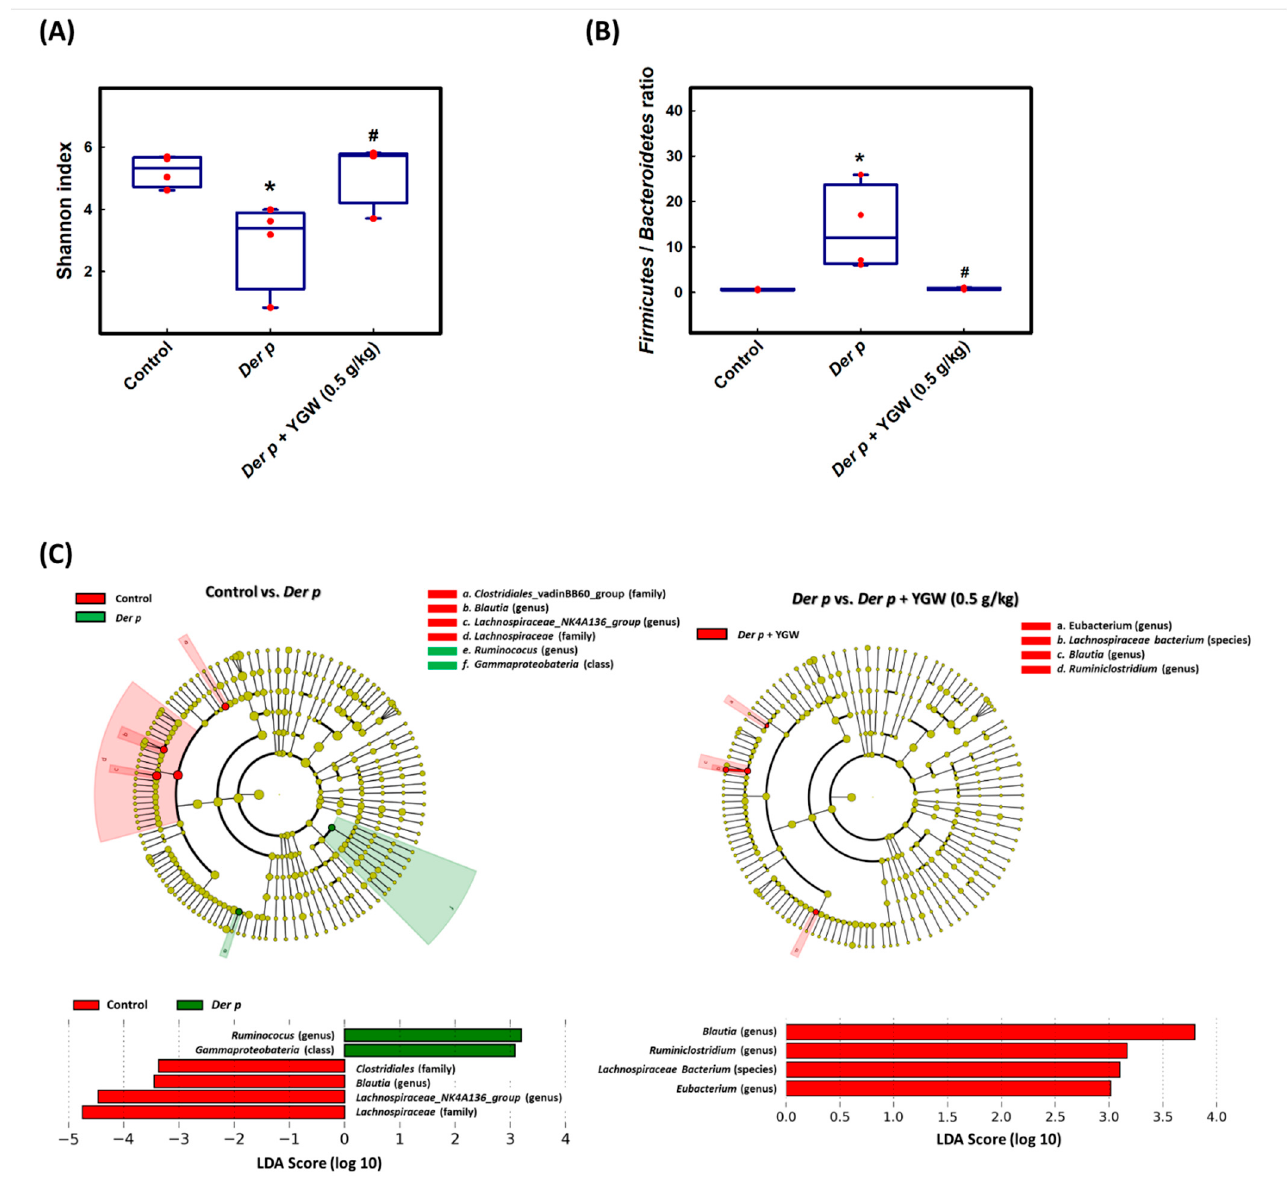
Figure 4. Summary of gut microbiota affected by Der p -induced asthma and YGW treatment in mice. ( A ) Gut microbiota indicated by Shannon diversity index compared among control, Der p , and Der p + YGW (0.5 g/kg) groups. ( B ) Ratios of Firmicutes / Bacteroidetes are relative abundance. ( C ) Cladogram generated from LEfSe analysis shows the association between taxon (the levels represent, from inner to outer rings, phylum, class, order, family, and genus). Data are mean ± SEM. * p < 0.05 (vs control); # p < 0.05 (vs Der p).